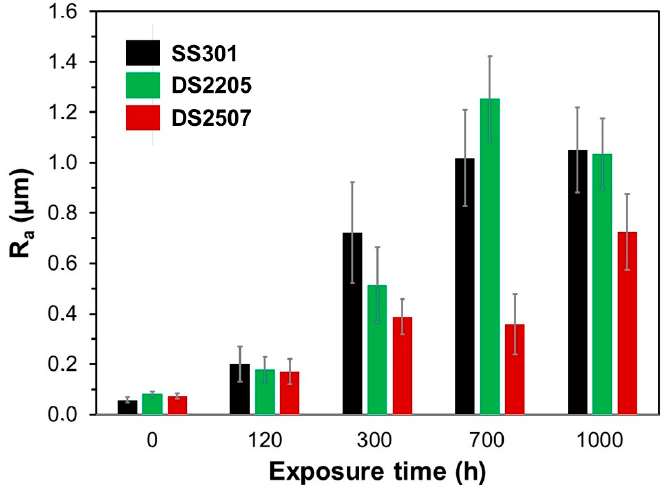
Figure 8. Surface roughness parameter ( R a ) of the oxide scales, determined from contact profilome- ter, formed on the SS301, DS2205 and DS2507 surfaces after exposing to molten salts for different times.